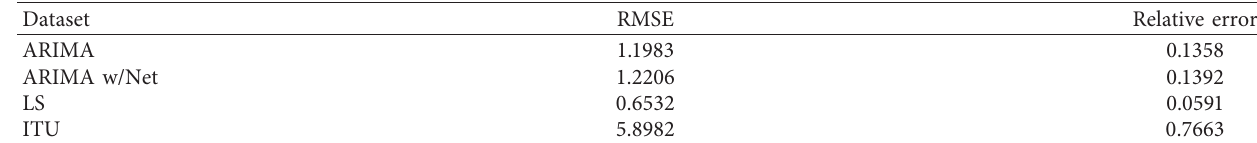
Table 17: ARIMA, ARIMA with neural network, LS, and ITU errors for